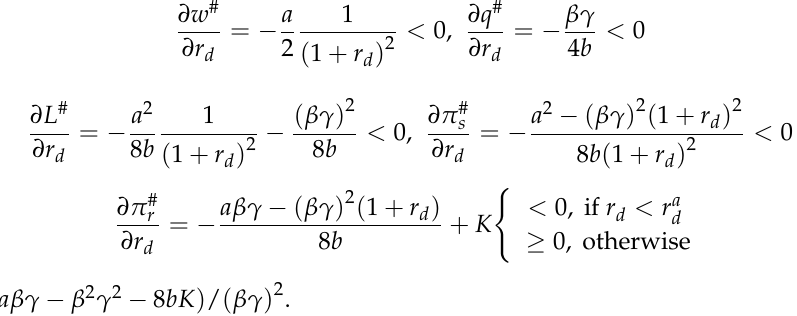
17 of 22 Figure A1. The schematic profit function of the supplier for Case A5.